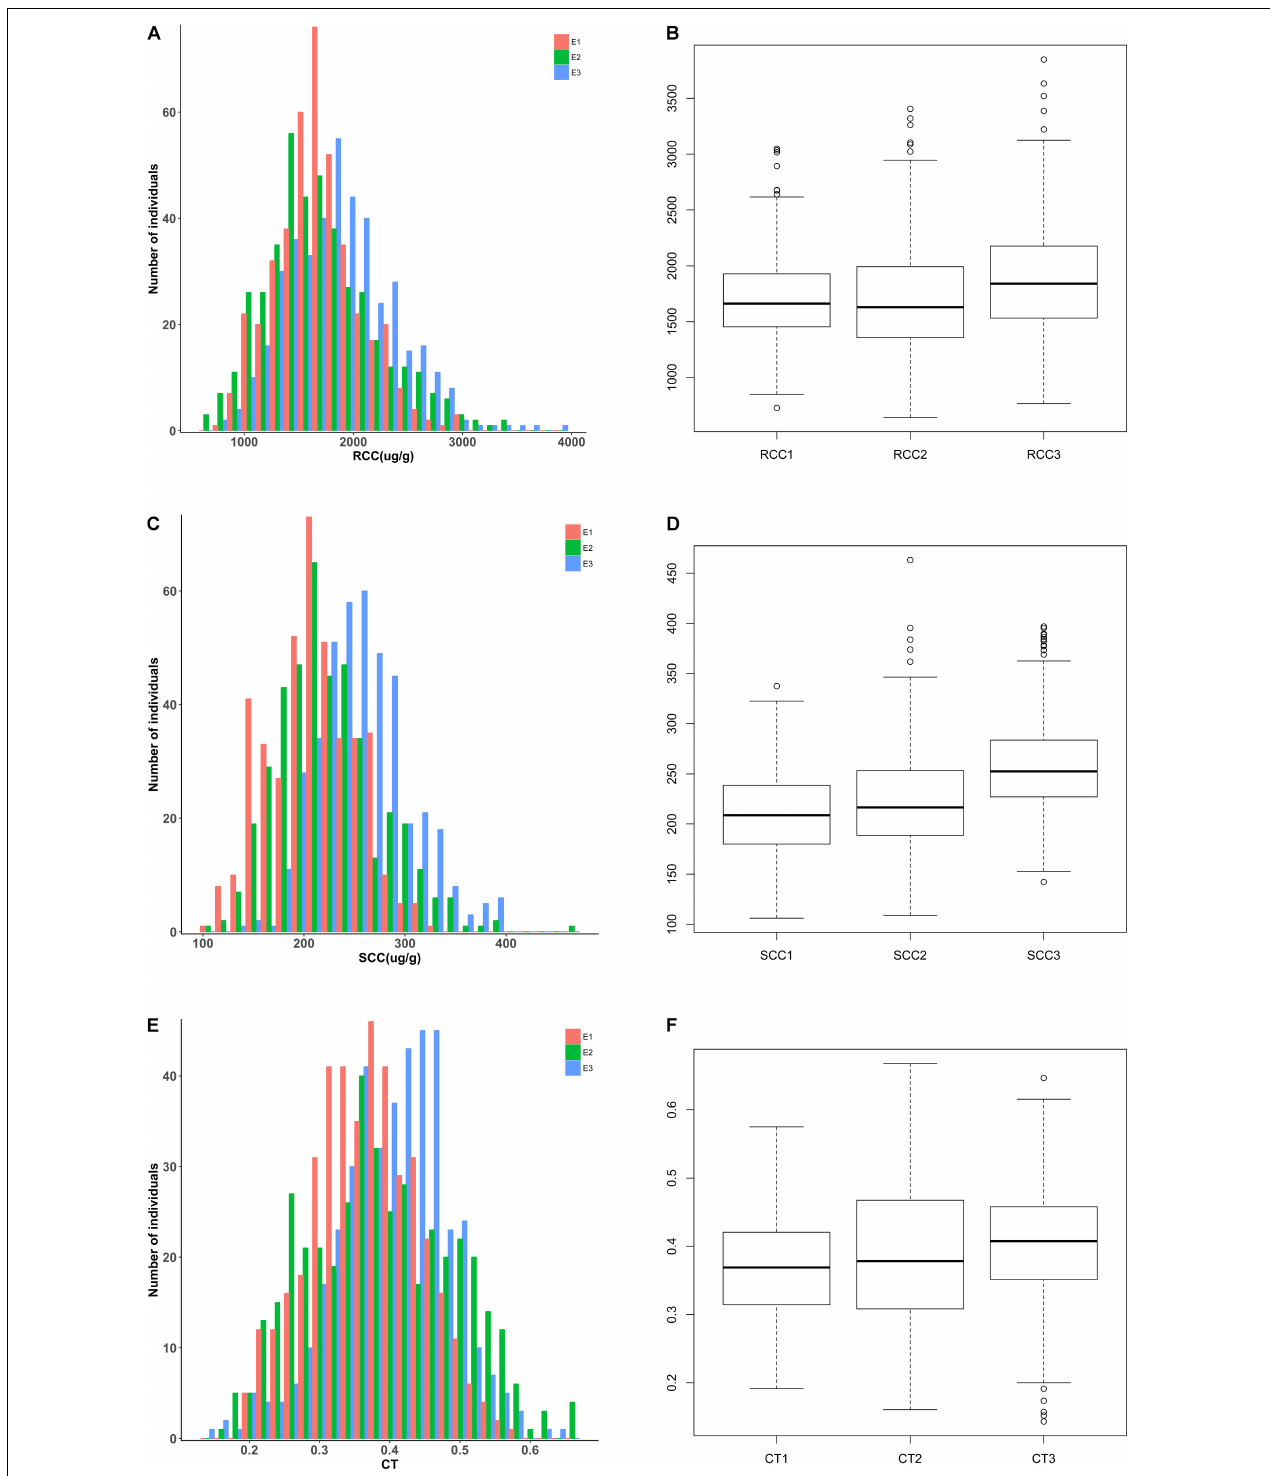
FIGURE 1 | Genetic variation for Cd accumulation in root, shoot, and root/shoot translocation in the association panel of 419 accessions grown in three environments. (A,B) Root Cd concentration; (C,D) shoot Cd concentration; (E,F) Cd translocation coefficient. SCC1, shoot Cd concentration in E1; RCC1, root Cd concentration in E1; CT1, Cd translocation coefficient in E1; SCC2, shoot Cd concentration in E2; RCC2, root Cd concentration in E2; CT2, Cd translocation coefficient in E2; SCC3, shoot Cd concentration in E3; RCC3, root Cd concentration in E3; CT3, Cd translocation coefficient in E3. E1, greenhouse in 2013; E2, greenhouse in 2014; E3, natural environment condition in